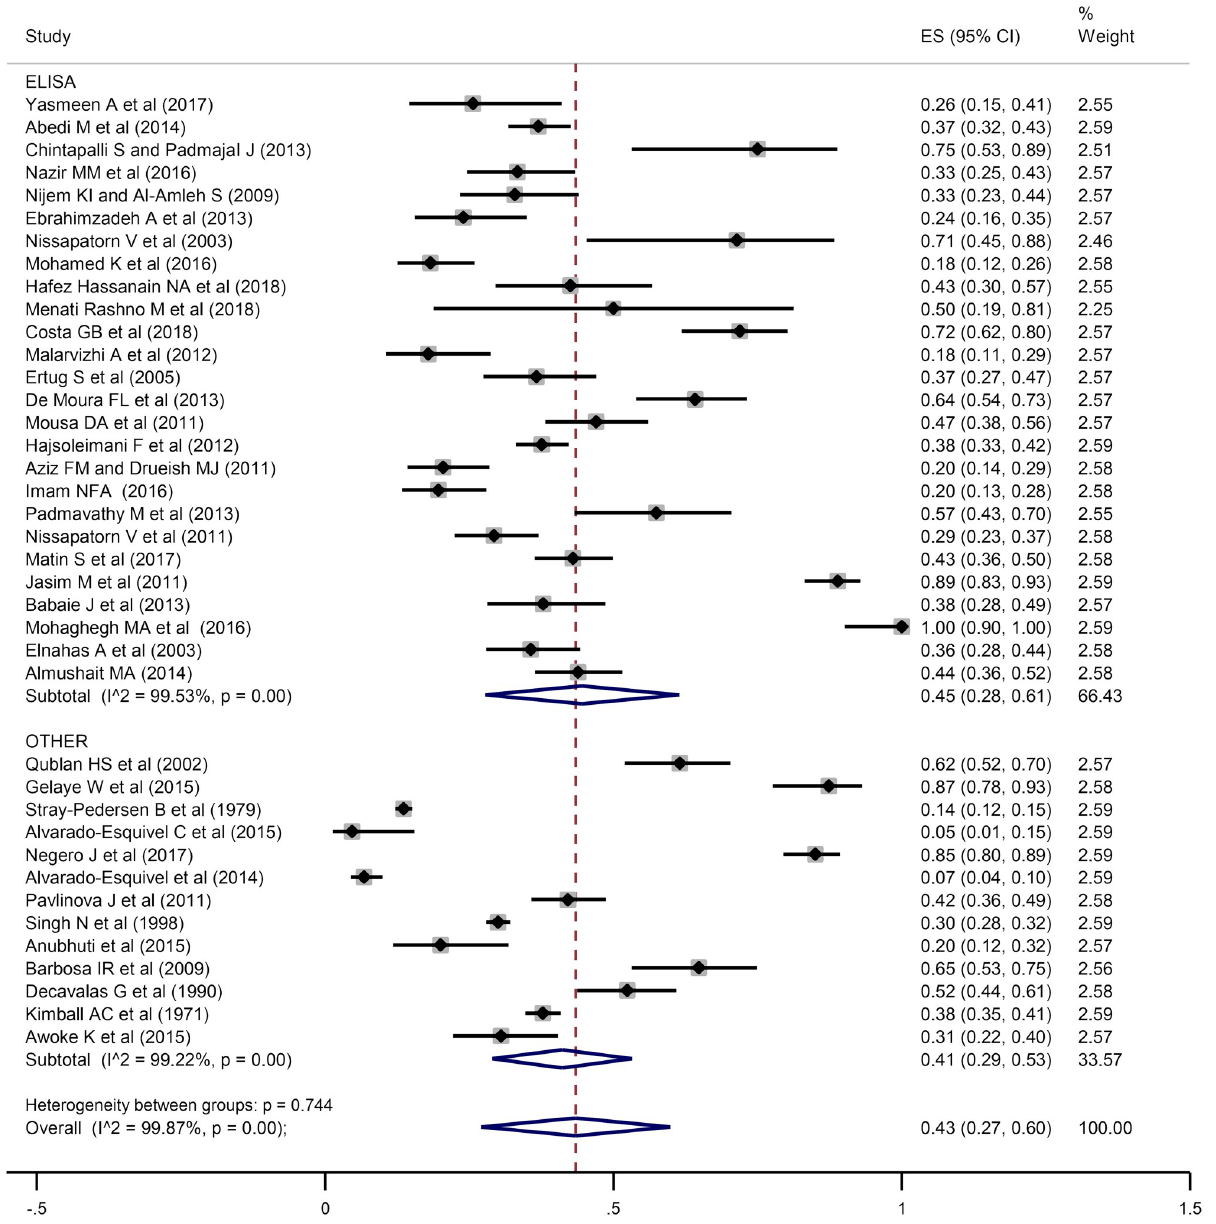
Fig 2. The reported seroprevalence of anti- T . gondii IgG antibody in women who had a history of abortion. The horizontal lines define the reported 95% confidence interval for the seroprevalence in each study, and the diamond below the graph shows the pooled seroprevalence. between the seroprevalence of anti- T . gondii antibodies and abortion. The obtained results indicated that the overall estimation for the prevalence of anti- T . gondii IgG antibodies in women who had a history of abortion (43%; 95% CI: 27%-60%) was higher than those with present abortion (33%; 95% CI: 17%-49%). According to Figs 2 and 3, the highest and lowest seroprevalence rates of anti- T . gondii antibodies in women who had a history of abortion were related to the studies performed by Mohaghegh et al . as 100% (95% CI: 0–100%) [83] and Alvarado-Esquivel et al . as 5% (95% CI: 1–15%) [80]. Additionally, the highest and lowest